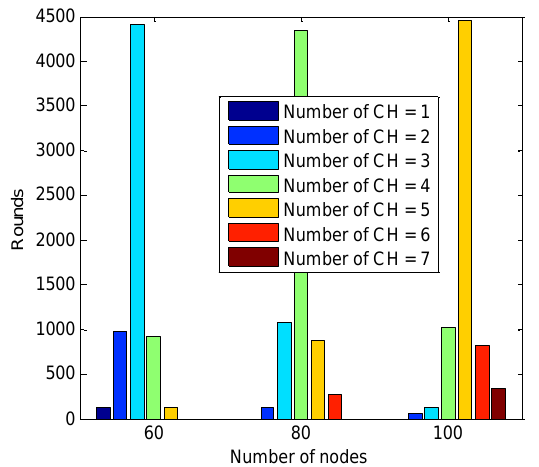
Figure 7. Comparison of the statistics of the number of CHs formed.